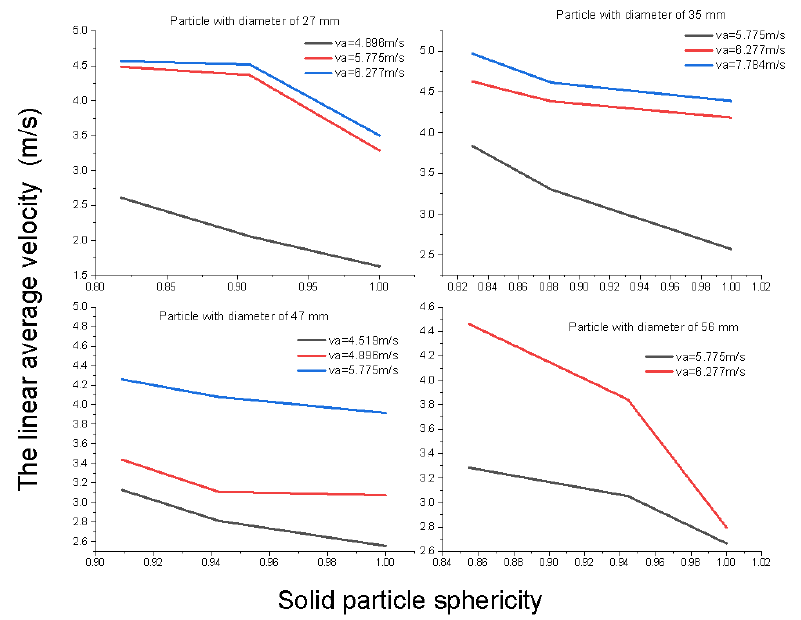
Figure 2. The variation of the linear average velocity on function by the variation of the airflow velocity and the variation of the solid particle shape for particles of different sizes [Reprinted/adapted with permission from Ref. [19]. Ristea M, 2020.